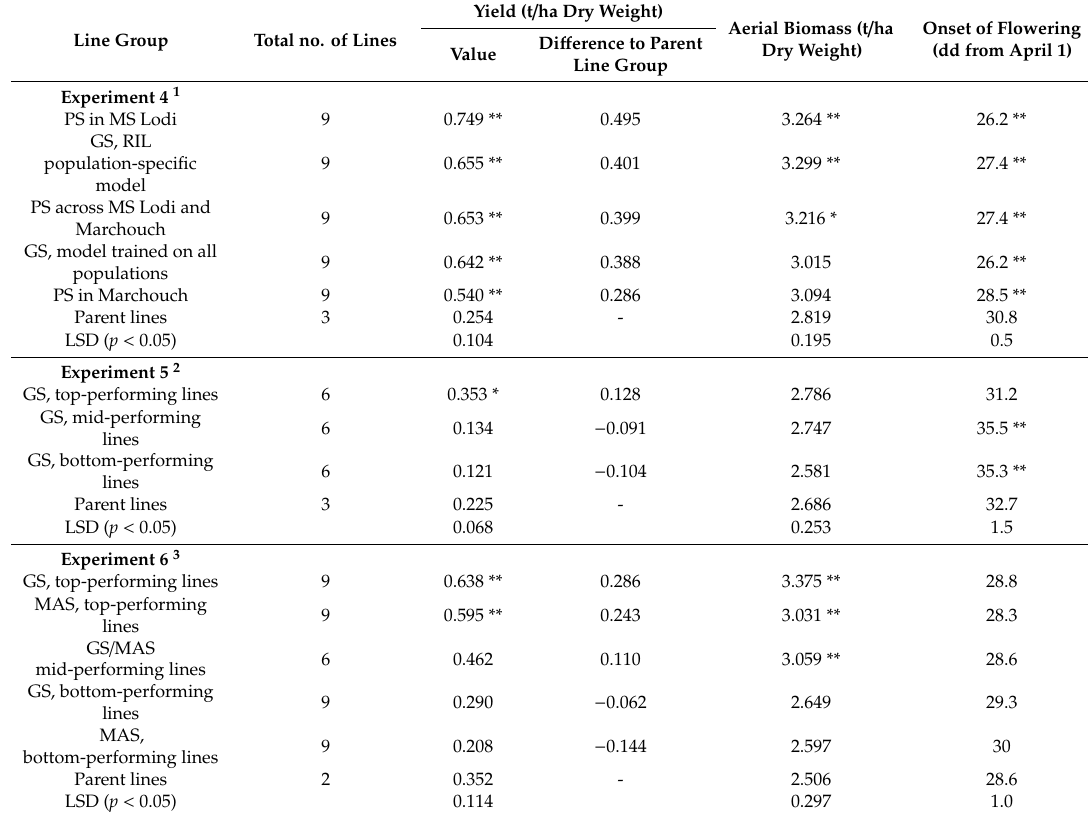
GS modelling based on data of independent lines evaluated in a MS experiment in Lodi and a field experiment in Marchouch (Exp. 1 and 2 in Table 1, respectively). LSD relates to line group mean comparison, excluding parent lines. Line group means followed by * and ** di ff er at p < 0.05 and p < 0.01, respectively, from the parent line mean according to Dunnett’s test. 1 GS model trained on 205 lines from three RIL populations or on the single populations. GS and PS selection: three lines out of 30, for each of three RIL populations. GS and PS data averaged across populations. 2 GS model trained on 295 lines from three RIL populations. Each GS-based line group: two lines out of 30, for each of three connected crosses. GS data averaged across connected crosses. 3 GS model trained on 198 lines from two RIL populations. GS and MAS selection: applied to 24 lines previously selected for